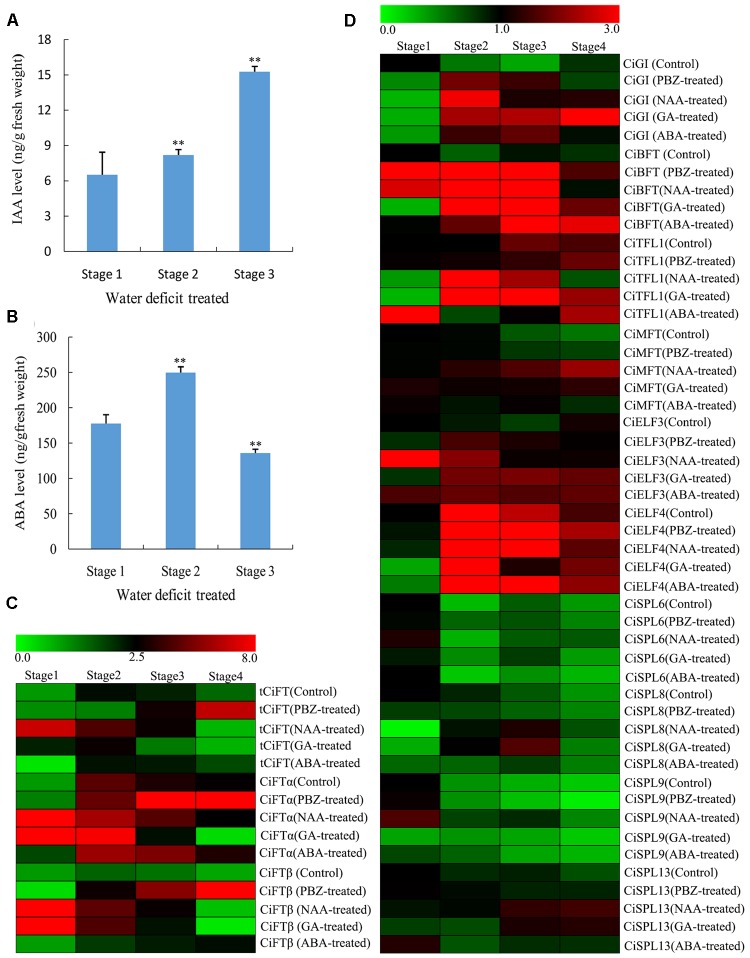
Changes of different hormone contents of lemon buds during floral inductive water deficits and the expression pattern of DEGs by different hormone treatments. (A) Changes in IAA content (ng/g fresh weight) in lemon buds (Stage 1: 1 week before water deficit; stage 2: 1 week after the beginning of water deficit; and stage 3: 1 week after releasing from water deficit). The data were processed using ANOVA, and statistical differences were compared based on Student’s t-test, taking P < 0.01 as ∗∗. (B) Changes in ABA content (ng/g fresh weight) in lemon buds (Stage 1: 1 week before water deficit; stage 2: 1 week after the beginning of water deficit; and stage 3: 1 week after releasing from water deficit). The data were processed using ANOVA, and statistical differences were compared based on Student’s t-test, taking P < 0.01 as ∗∗. (C) Heat map showing the expression of total CiFT (tCiFT), CiFTα, and CiFTβ in plant lemon leaves treated with PBZ, NAA, GA3, and ABA treatments. Plant materials from PBZ-treated, GA3-treated, ABA-treated, NAA-treated, and water-treated trees were collected at four stages (stage 1, stage 2, stage 3, and stage 4). (D) Heat map showing the expression of CiGI (Cs3g21790), CiBFT (Cs8g15080), CiMFT (Cs2g06960), CiELF3 (Cs1g19130), CiELF4 (Cs7g31110), CiSPL6 (Cs5g12260), CiSPL8 (Cs1g03630), CiSPL9 (orange1.1t02265), and CiSPL13 (orange1.1t02597) in lemon buds during PBZ, NAA, GA3, and ABA treatments. Plant materials from PBZ-treated, GA3-treated, ABA-treated, NAA-treated, and water-treated trees were collected at four stages (stage 1, stage 2, stage 3, and stage 4). Three independent biological replications of each sample and four technical replications of each biological replication were used for real-time PCR analysis. Genes highly or weakly expressed in the tissues are colored red and green, respectively. The heat map was generated using Cluster 3.0 software.